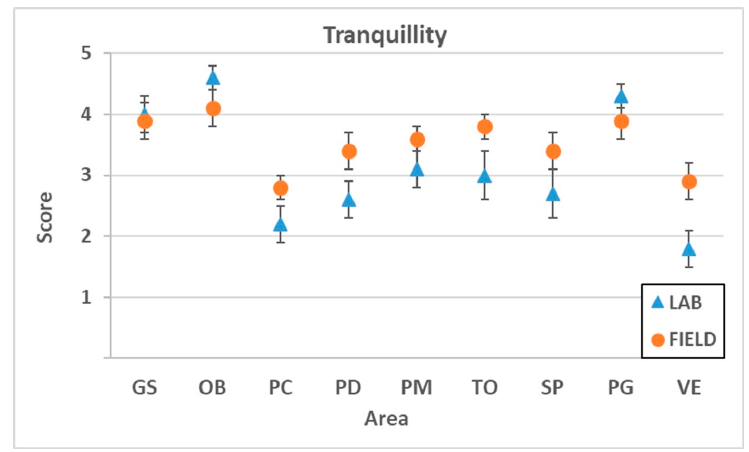
Figure 5. Tranquillity scores in laboratory and in field campaigns. Environments 2018 , 5 , 1